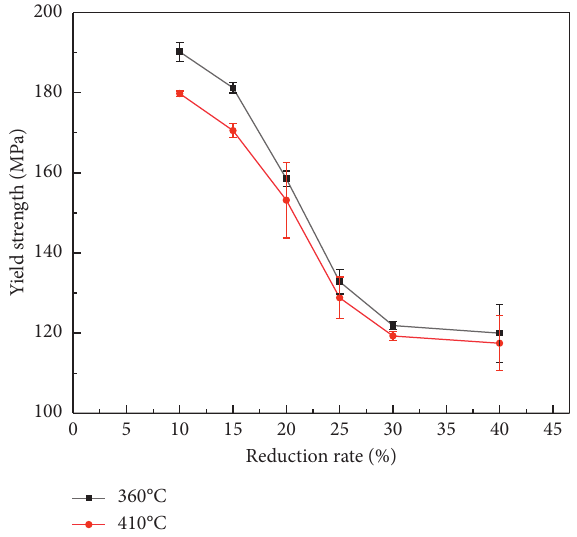
Figure 10: Yield strength versus rate of reduction upon